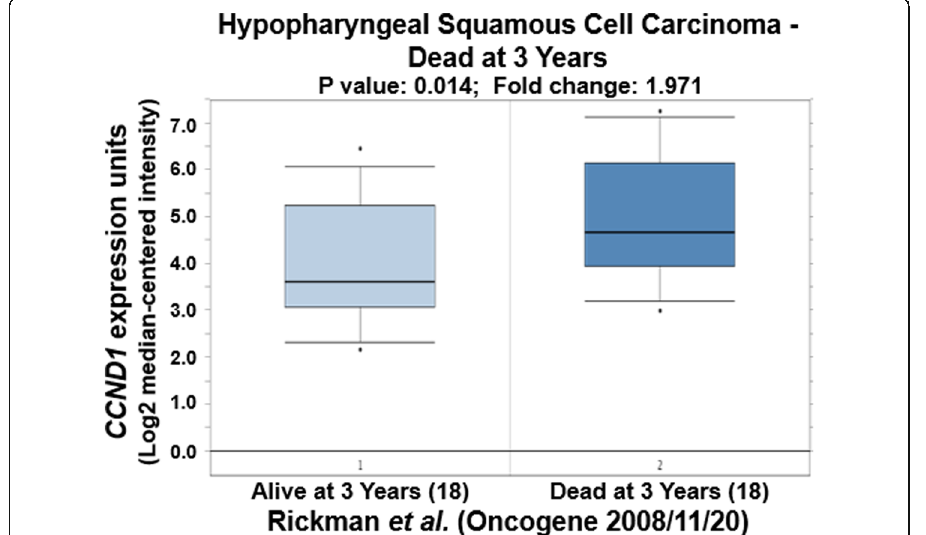
Fig. 8 Comparison of CCND1 expression in hypopharyngeal squamous cell